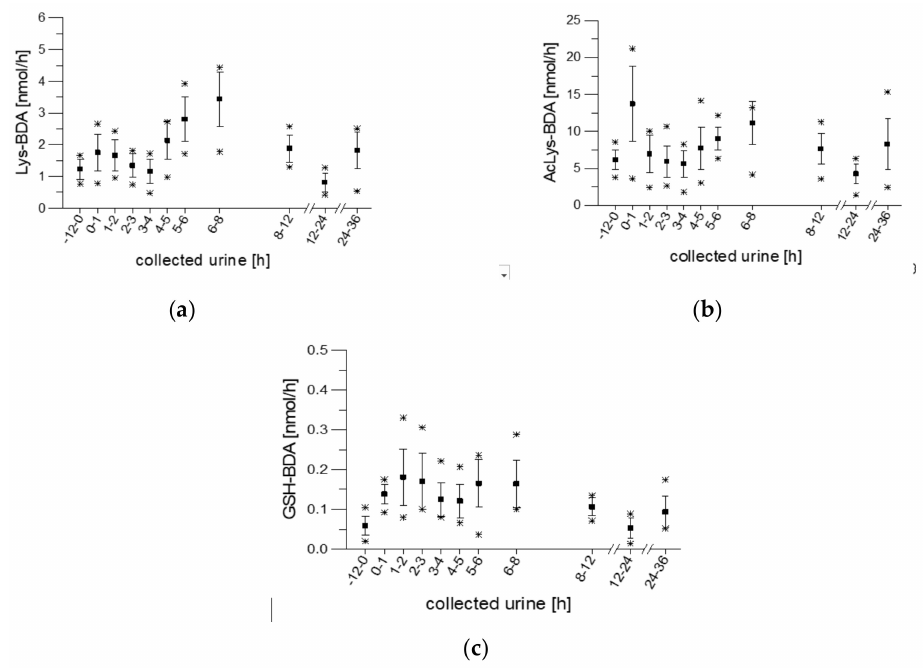
Figure 1. Excretion kinetics of Lys-BDA ( a ), AcLys-BDA ( b ), and GSH-BDA ( c ): HPLC-ESI-MS / MS measurements of contents in samples of urine from participants 1 to 10 at indicated times after co ff ee consumption (h). Data are previously published means with standard deviations and minimum / maximum values